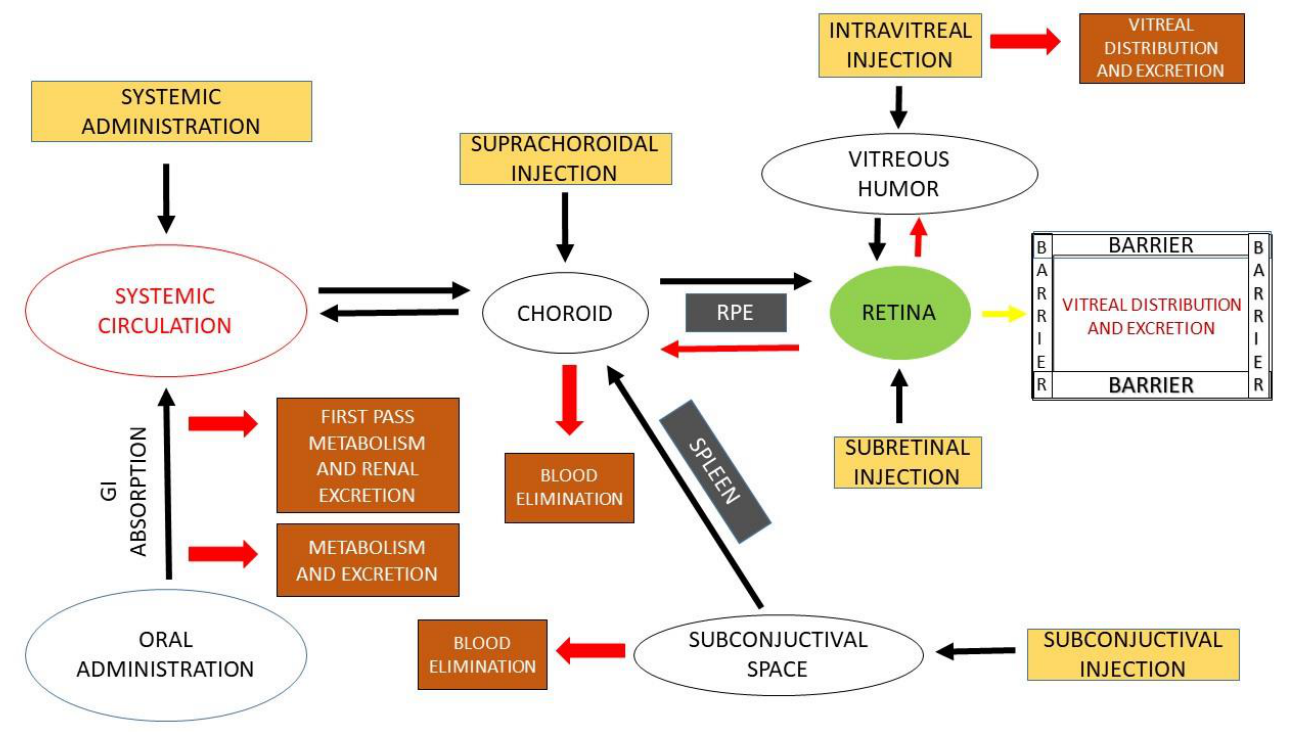
Figure 2. Different routes for ocular drug clearance/elimination.